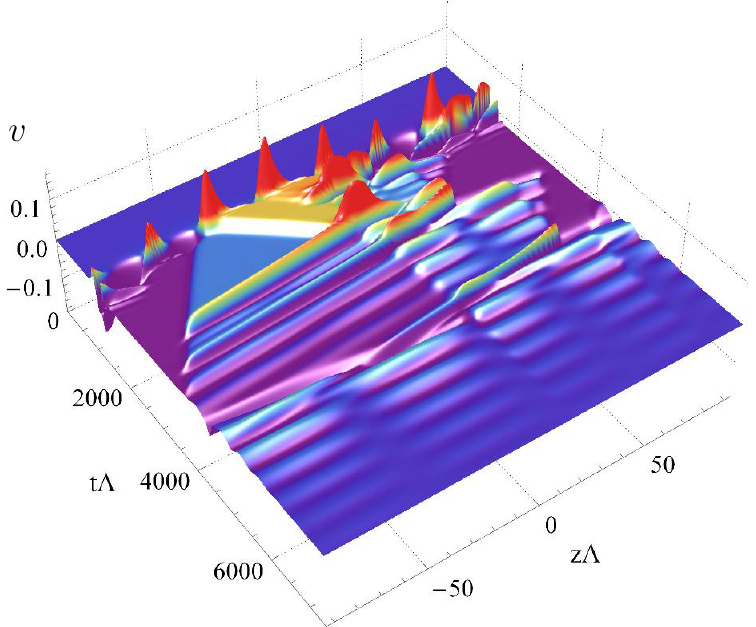
Figure 31 . Velocity of the (cid:13)uid in the evolution of (cid:12)gure 4(left).